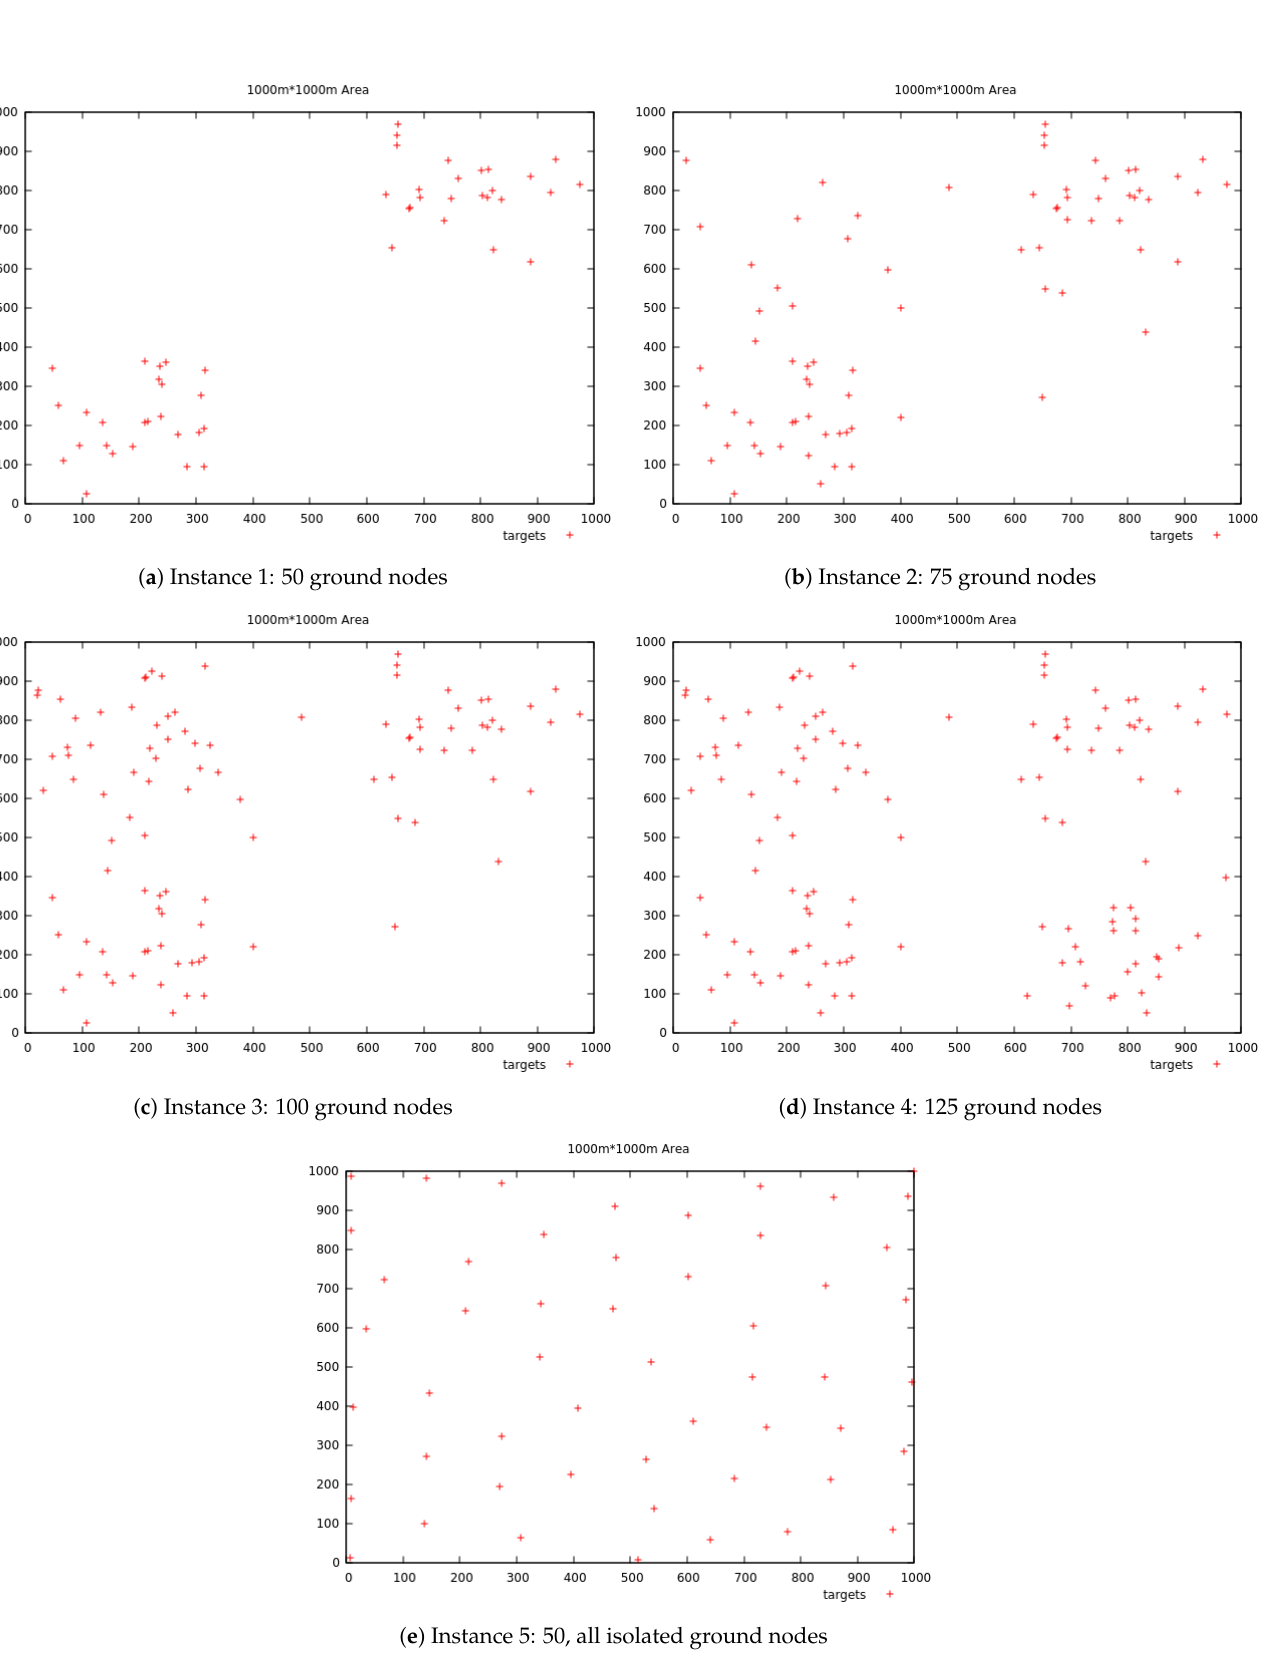
Figure 6. Distribution of the different test